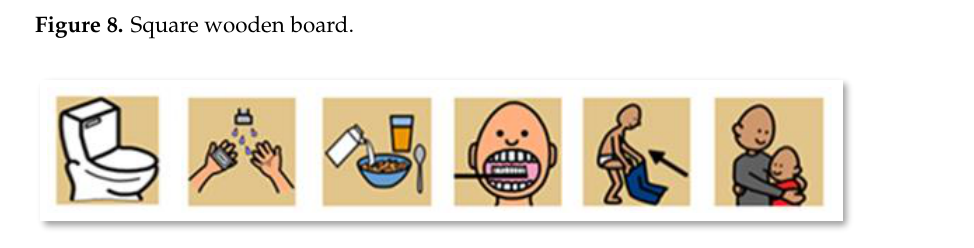
Figure 9. Square wooden block.